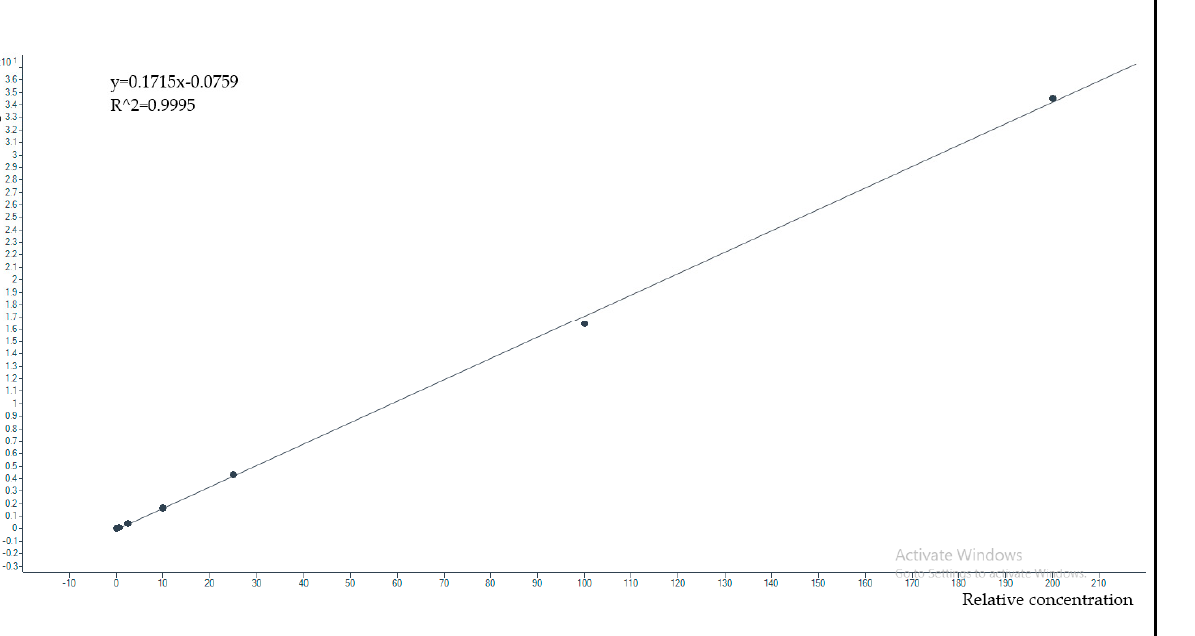
Figure 3. Example of a calibration obtained by plotting the C/C-d12 area ratio (response) over concentration, in the 0.1200.0 mg/L range, by software fitting of the 7 experimental calibration points with the linear equation and correlation coefficient reported in the upper left corner of the box, both indicating stringent linearity of the calibration model.